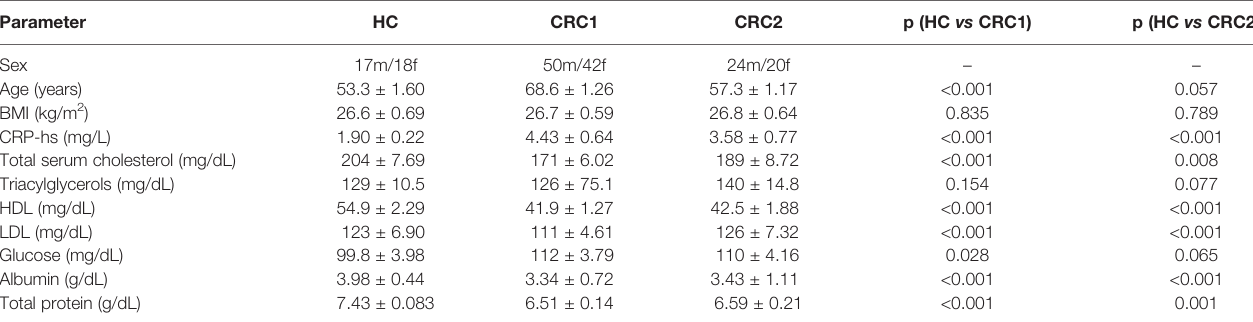
TABLE 1 | Biochemical characteristics of the study subjects.